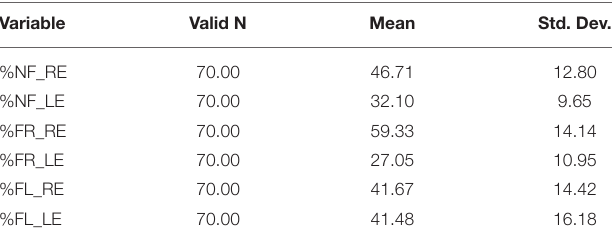
TABLE 1 | Mean and SD percentage scores for the right (RE) and left (LE) ear split for the three attention instruction conditions (NF, FR, and FL). Variable